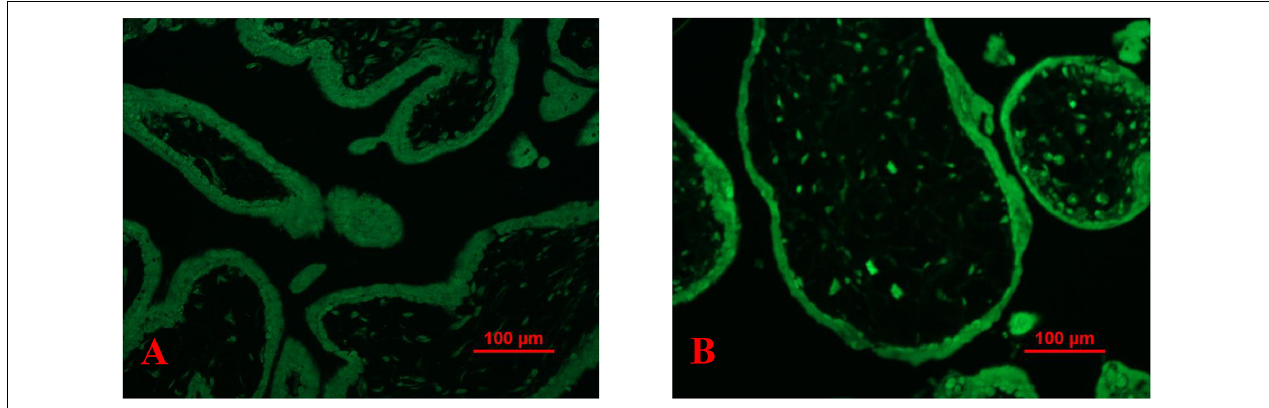
FIGURE 5 | Representative fluorescent compound ThT staining image of a thin section of a placental explant showing that the intensity of ThT (green) was increased in placentas that had been treated H 2 O 2 (B) compared to untreated (A) .